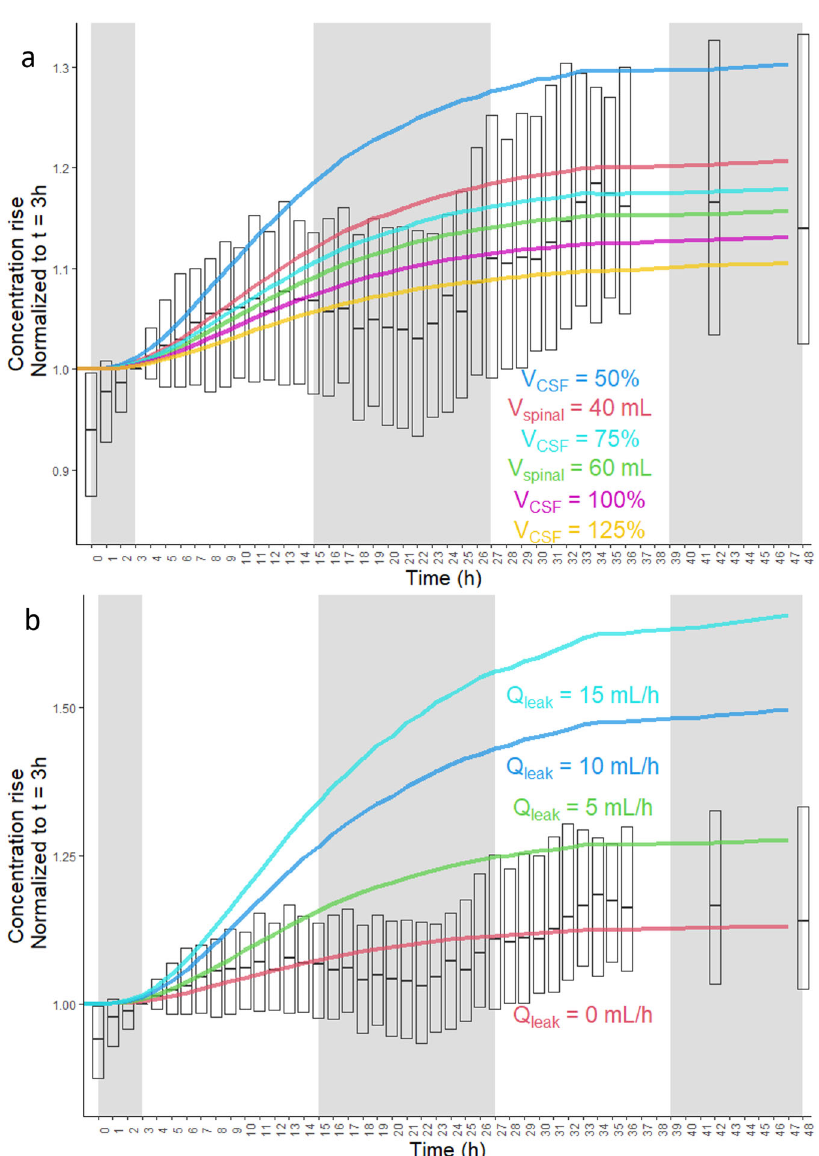
Fig. 2 Increasing lumbar A β CSF concentration due to hourly CSF withdrawal. Normalized lumbar CSF concentrations of A β peptides averaged over all subjects ( n = 96). Lumbar CSF A β concentration time courses for each subject were fi rst normalized to time = 3 h to account for the sleep effect from the previous night (experiments started at 8 a.m.). The A β concentration was the average of A β 38 , A β 40 , and total A β for each subject (total A β was from an immunoprecipitation with an antibody recognizing a sequence common to A β 38 , A β 40 , and A β 42 ). Some subjects ( n = 17) only had concentration timecourse measured by ELISA for A β 40 and A β 42 . The ELISA time courses were averaged for these two peptides at each time point. a The total volume of CSF ( V CSF ) was scaled between 50 and 125% in separate simulations, and the volume of spinal CSF was varied from 40 to 80 mL. b The presence of a CSF leak around the catheter was also simulated, ranging from 0 to 20 mL/h, or equal to the entire CSF production rate ( Q leak = Q CSF ). Medians and means of measurements are shown, and bars represent the interquartile range. Shaded areas represent the sleep effect. Simulations of CSF leaks equal to 20 mL/h or Q CSF overlapped with Q leak = 15 mL/h. For the full boxplot of measured concentrations, see Supplementary Fig.